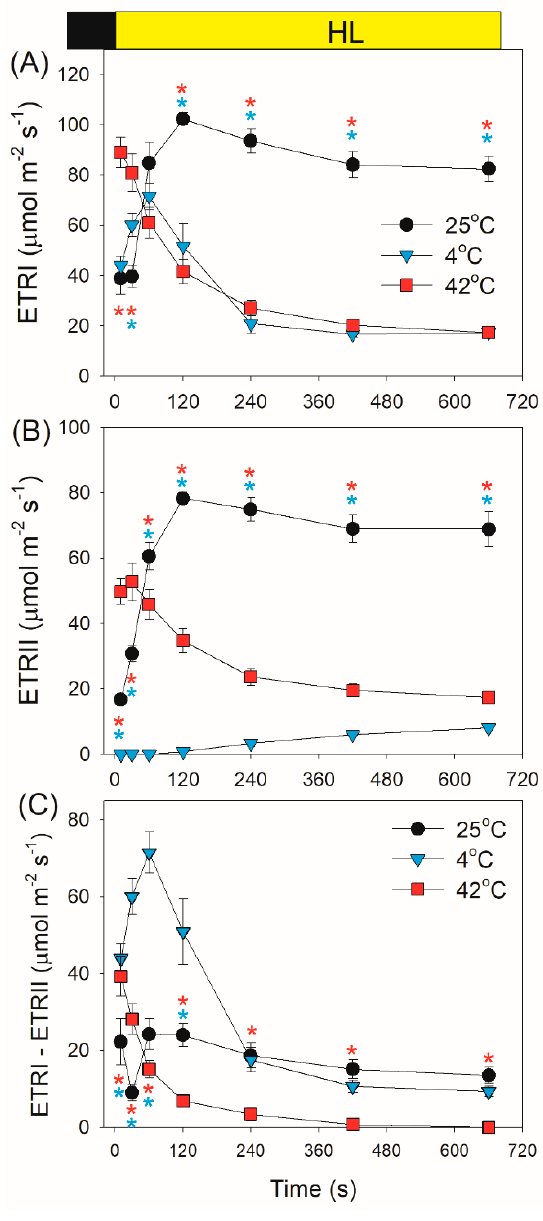
Figure 3. Changes in photosynthetic electron transport rates after transition from dark to actinic light (1455 μ mol photons m − 2 s − 1 ) at 25 °C, 4 °C, and 42 °C. ( A – C ) ETRI represents the photosyn- thetic transport rate through PSI; ETRII, the photosynthetic transport rate through PSII; ETRI– ETRII, the rate of cyclic electron flow (CEF). Values are means ± SE ( n = 5). Red asterisks indicate significant differences between 25 °C and 42 °C, and blue asterisks indicate significant differences between 25 °C and 4 °C.